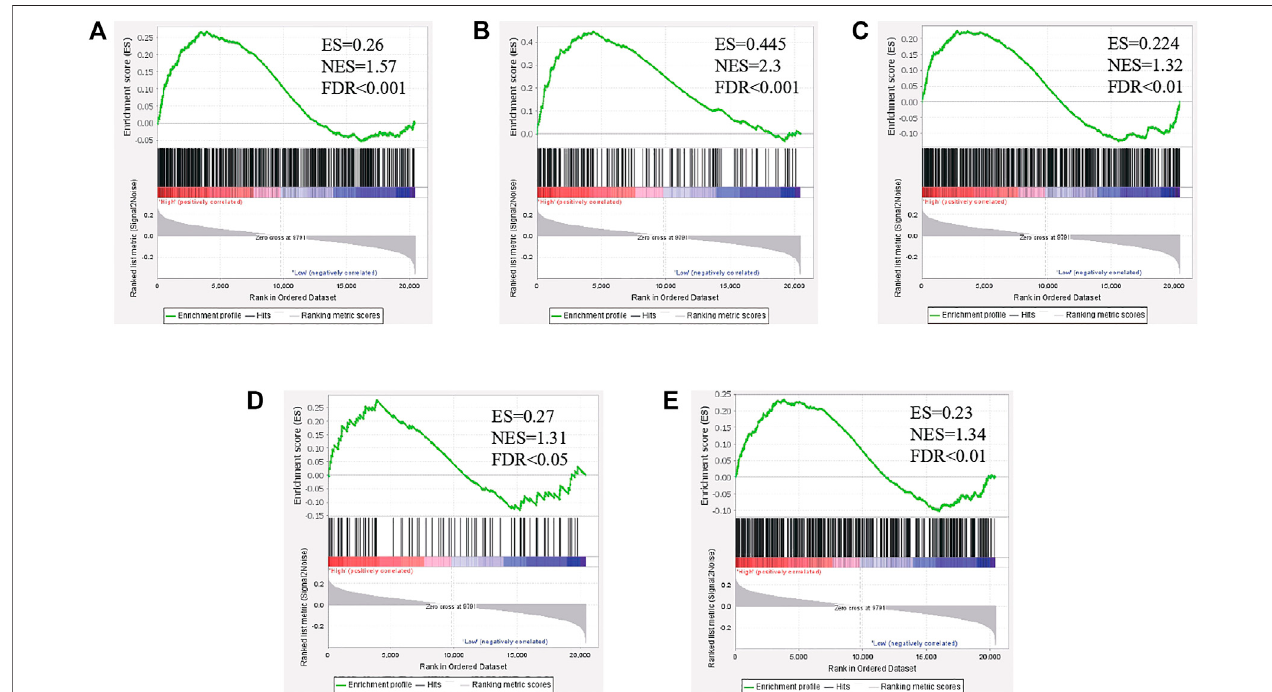
FIGURE 8 | The level of PLAGL2 was positively associated with migration, proliferation, cytoskeleton, and angiogenesis in clinical specimens. (A – E) Enrichment plots of gene expression signatures according to PLAGL2 mRNA expression levels by the GSEA of glioma databases GSE4290. HGG samples were divided into high and low PLAGL2 expression groups. Gene signatures of migration, proliferation, cytoskeleton, angiogenesis, and VEGF-VEGFR2 signaling pathway assembly were enriched in high-expression specimens compared to low-expression patients. False discovery rate (FDR) showed the estimated probability that a gene set with a given normalized ES (NES) represented a false-positive fi nding; FDR < 0.05 was a widely accepted cut-off for the identi fi cation of biologically signi fi cant gene